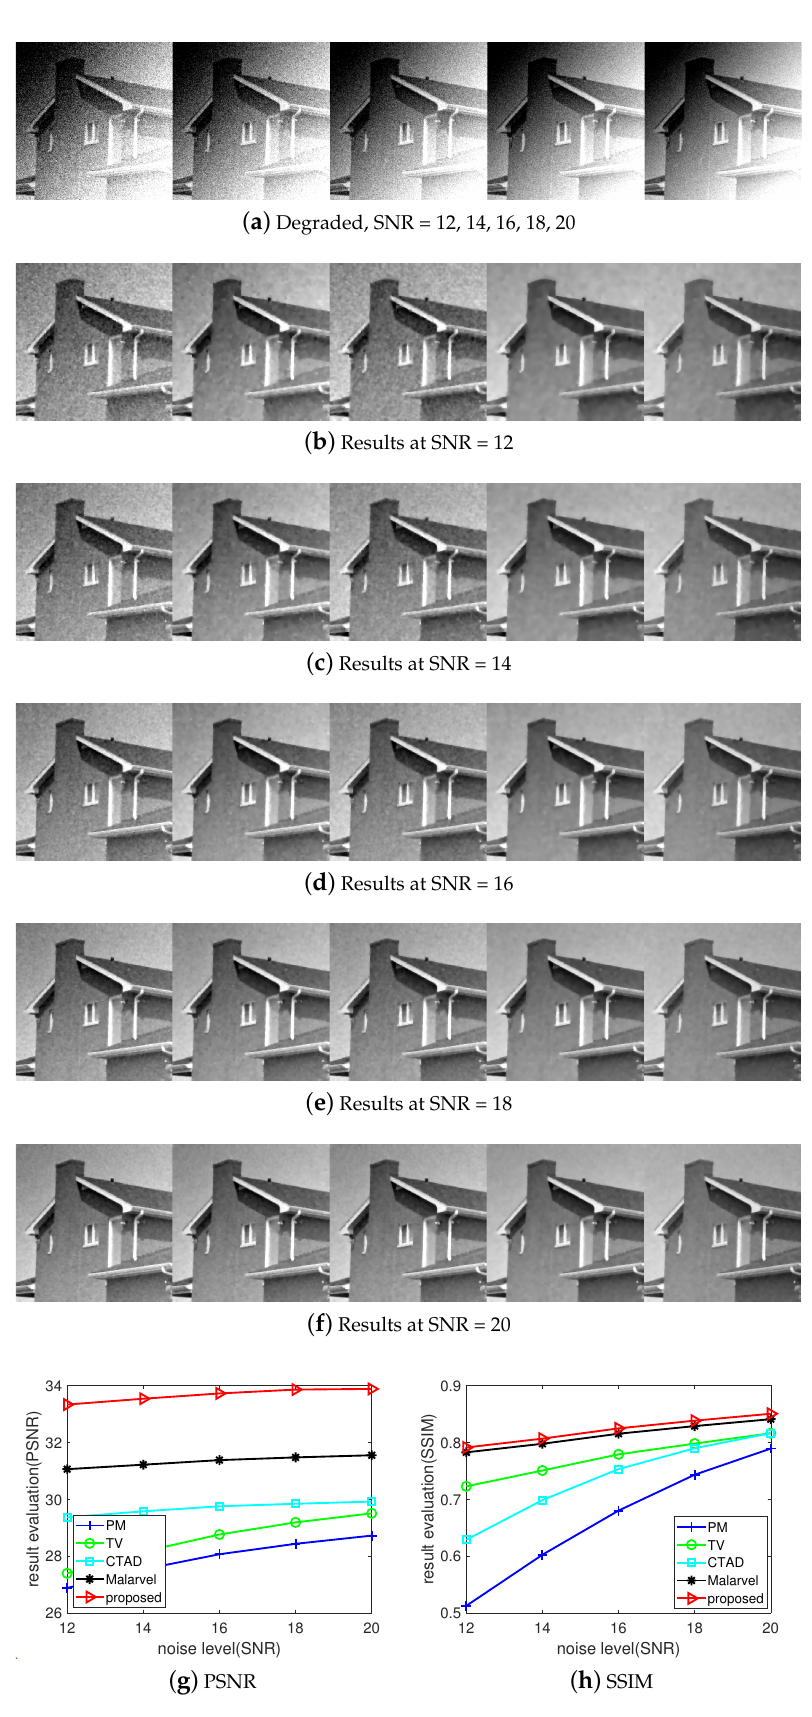
Figure 7. Results of House image in Experiment